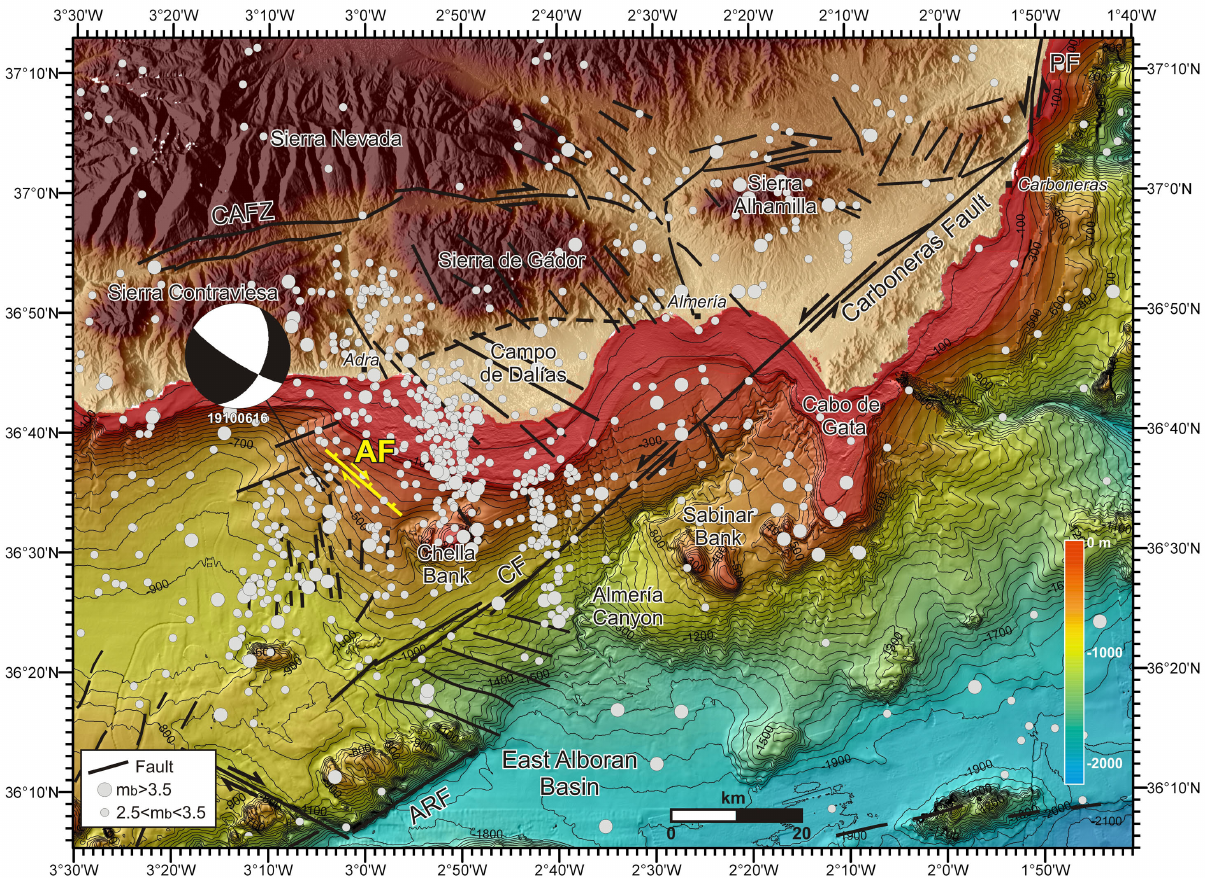
Fig. 7. Topographic and colour-shaded bathymetric map (isobaths every 50m) of the Almer´ıa–Adra margin. Seismicity from the Instituto Geogr´afico Nacional catalogue for the period between 1965 and 2010 is depicted (I.G.N., 2010). Grey dots correspond to epicentres of earthquakes for different magnitudes. Main active faults onshore and offshore are located in black. The normal-dextral Adra Fault is depicted in yellow. Moment tensor solution obtained for the 1910 Adra Earthquake is also located (Stich et al., 2003b). CAFZ: Corredor de las Alpujarras Fault Zone; CF: Carboneras Fault; PF: Palomares Fault; ARF: Adra Ridge